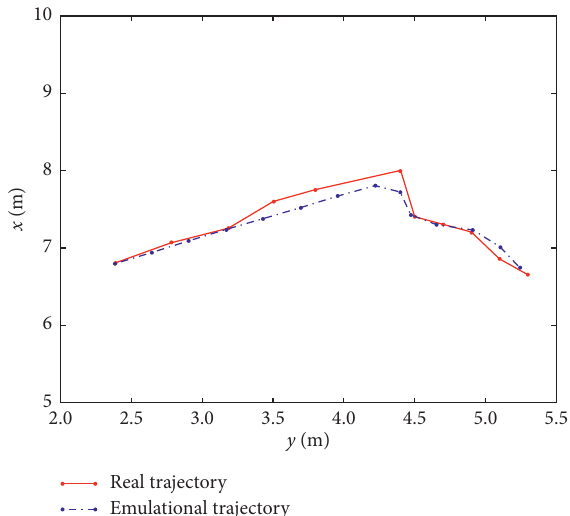
Figure 6: Comparison of passenger 1’s real and emulational trajectory.